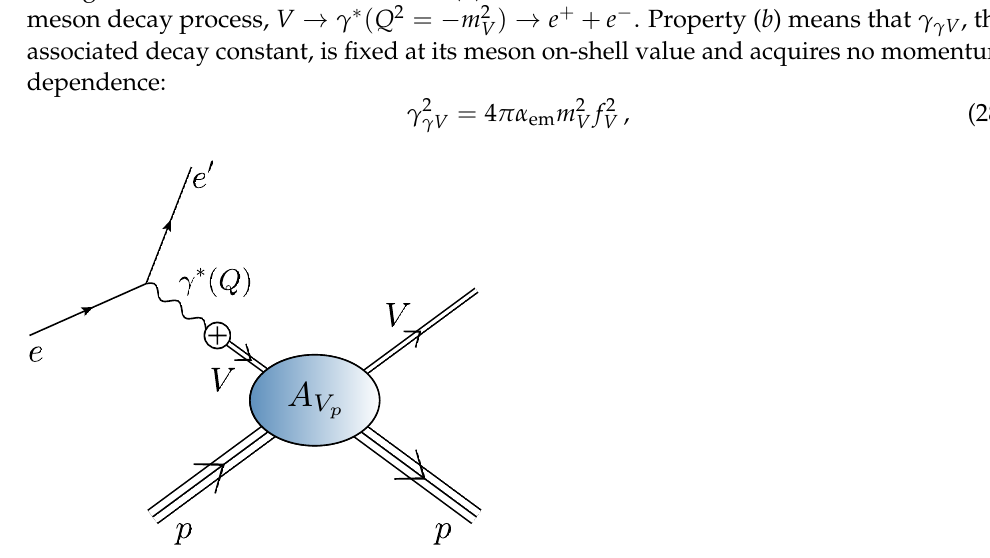
Figure 12. Electroproduction of a vector meson from the proton: e + p → e (cid:48) + V + p , often interpreted as providing access to V + p → V + p using a vector meson dominance model. The γ ( ∗ ) ( Q ) → V VMD transition is indicated by the crossed circle. It is usually assumed to occur with a momentum- independent strength γ γ V [320–322]. However, regarding heavy mesons, at least, the VMD hypothesis is unsound, as discussed below and in, e.g.,